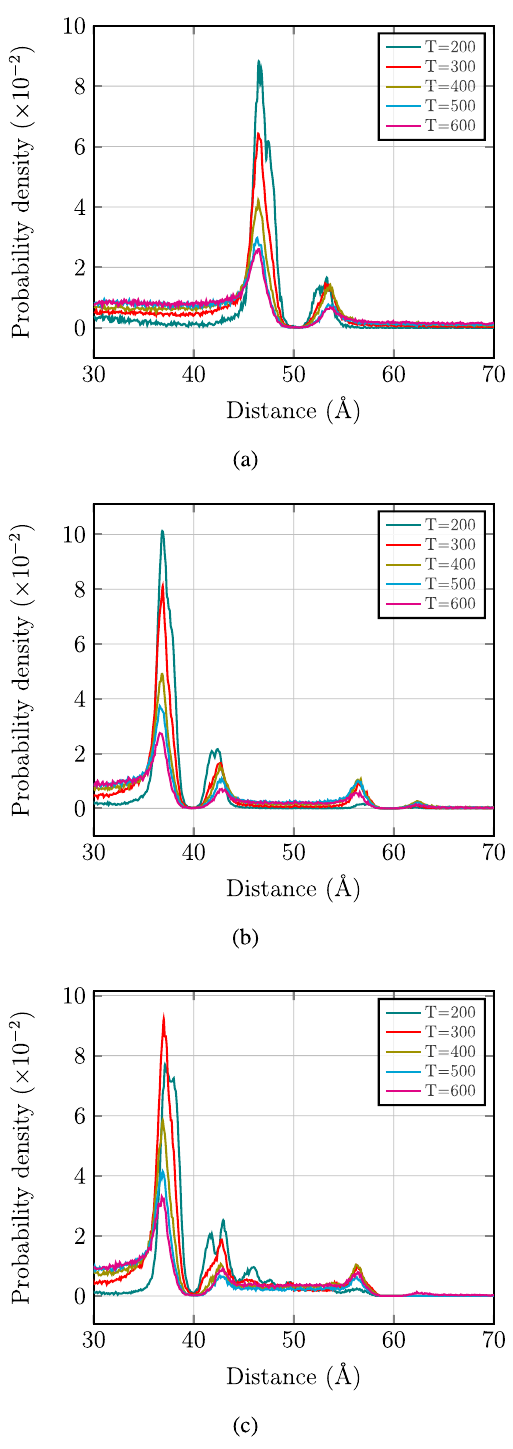
Figure 8. Probability density distribution of the CO 2 molecules passing through the GDY-H membrane at different temperatures as a function of distance in ( a ) monolayer, ( b ) two layers and ( c ) two layers of the membrane in the presence of